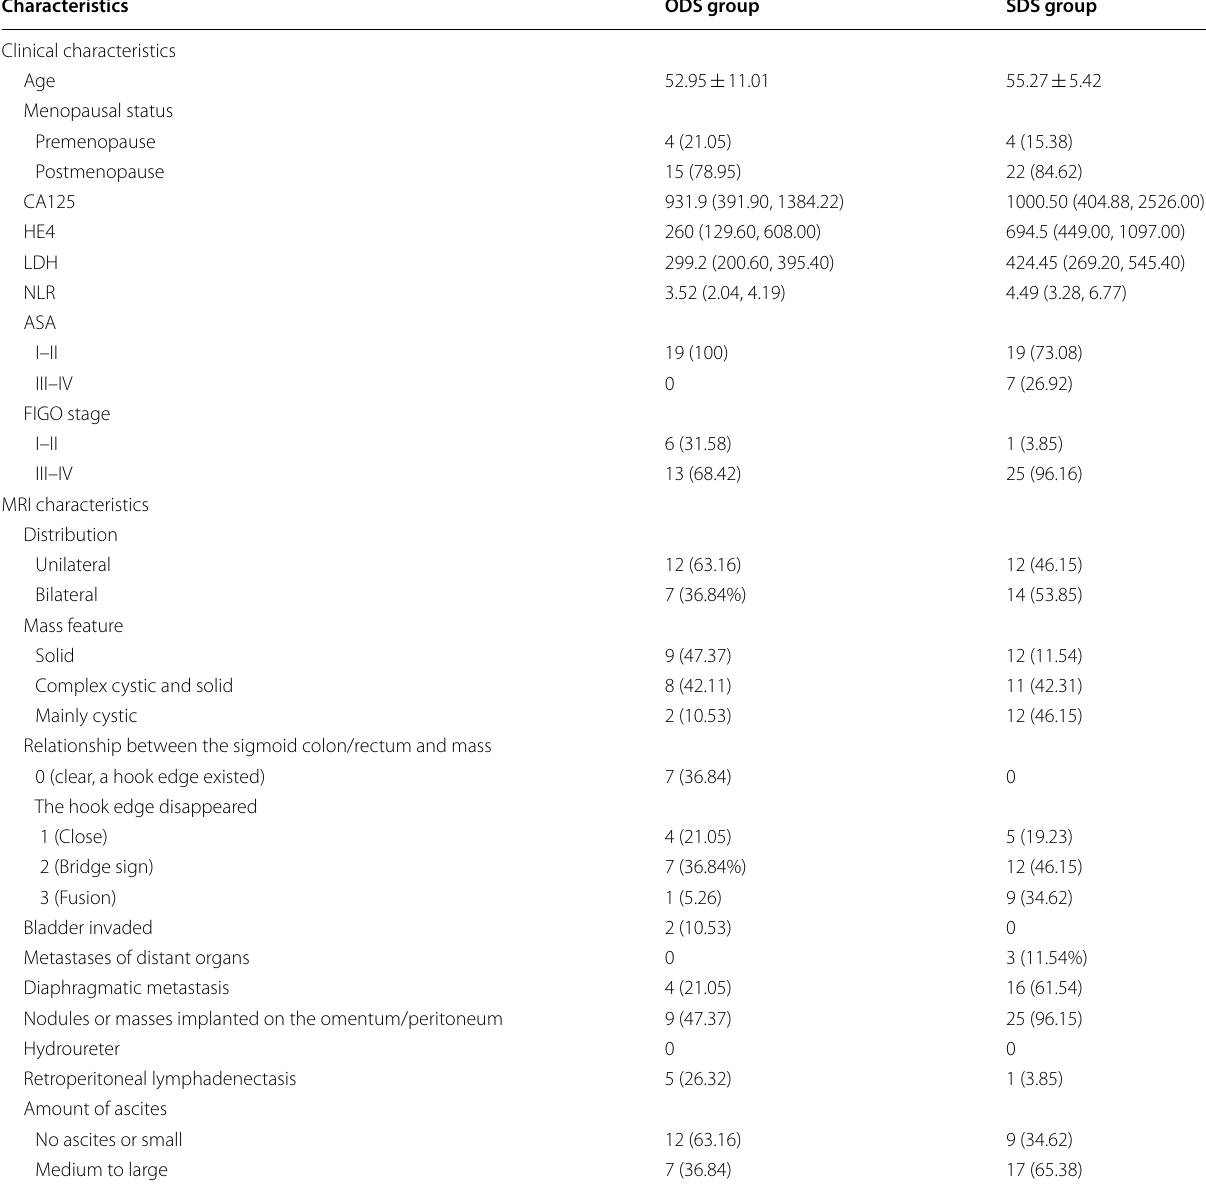
SOC Serous ovarian carcinoma, ODS optimal debulking surgery, SDS suboptimal debulking surgery